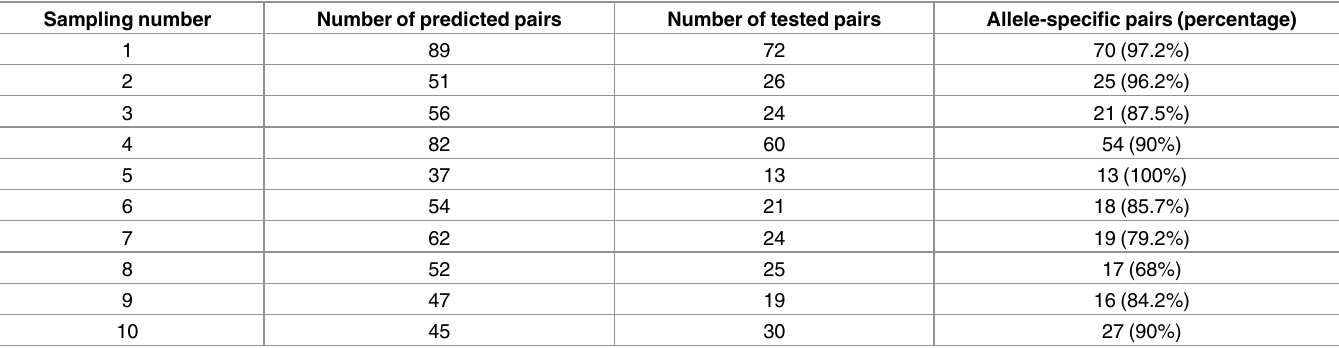
Table 1. Validation of predictive allelic